Question: In a single sentence, describe what this figure presents.
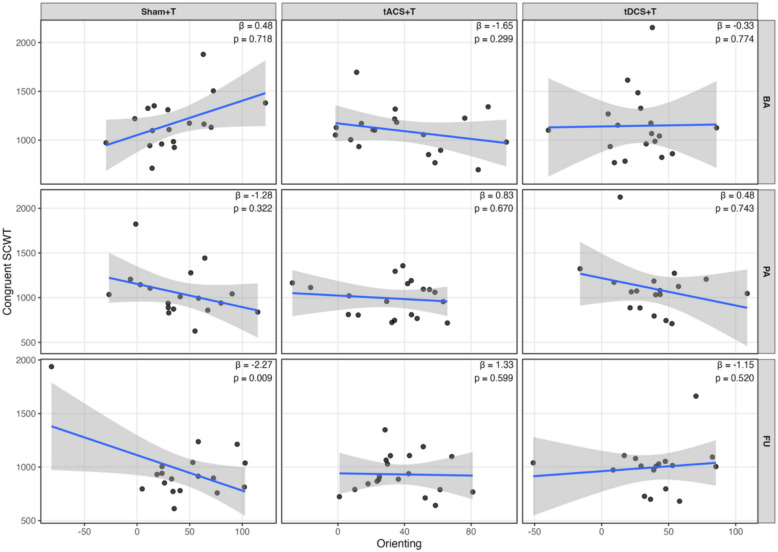
Answer: Scatterplots illustrating the association between orienting network efficiency and congruent reaction time (ms) across groups and time points. Each panel represents one group (columns: Sham + T, tACS + T, tDCS + T) and one assessment time (BA = baseline; PA = post-assessment; FU = follow-up). Dots represent individual participants, and solid lines indicate fitted linear regression lines with shaded areas representing 95% confidence intervals. The β coefficients and corresponding p-values are displayed in each panel. A significant negative association was observed in the Sham + T group at follow-up, while no significant associations were found in the other conditions